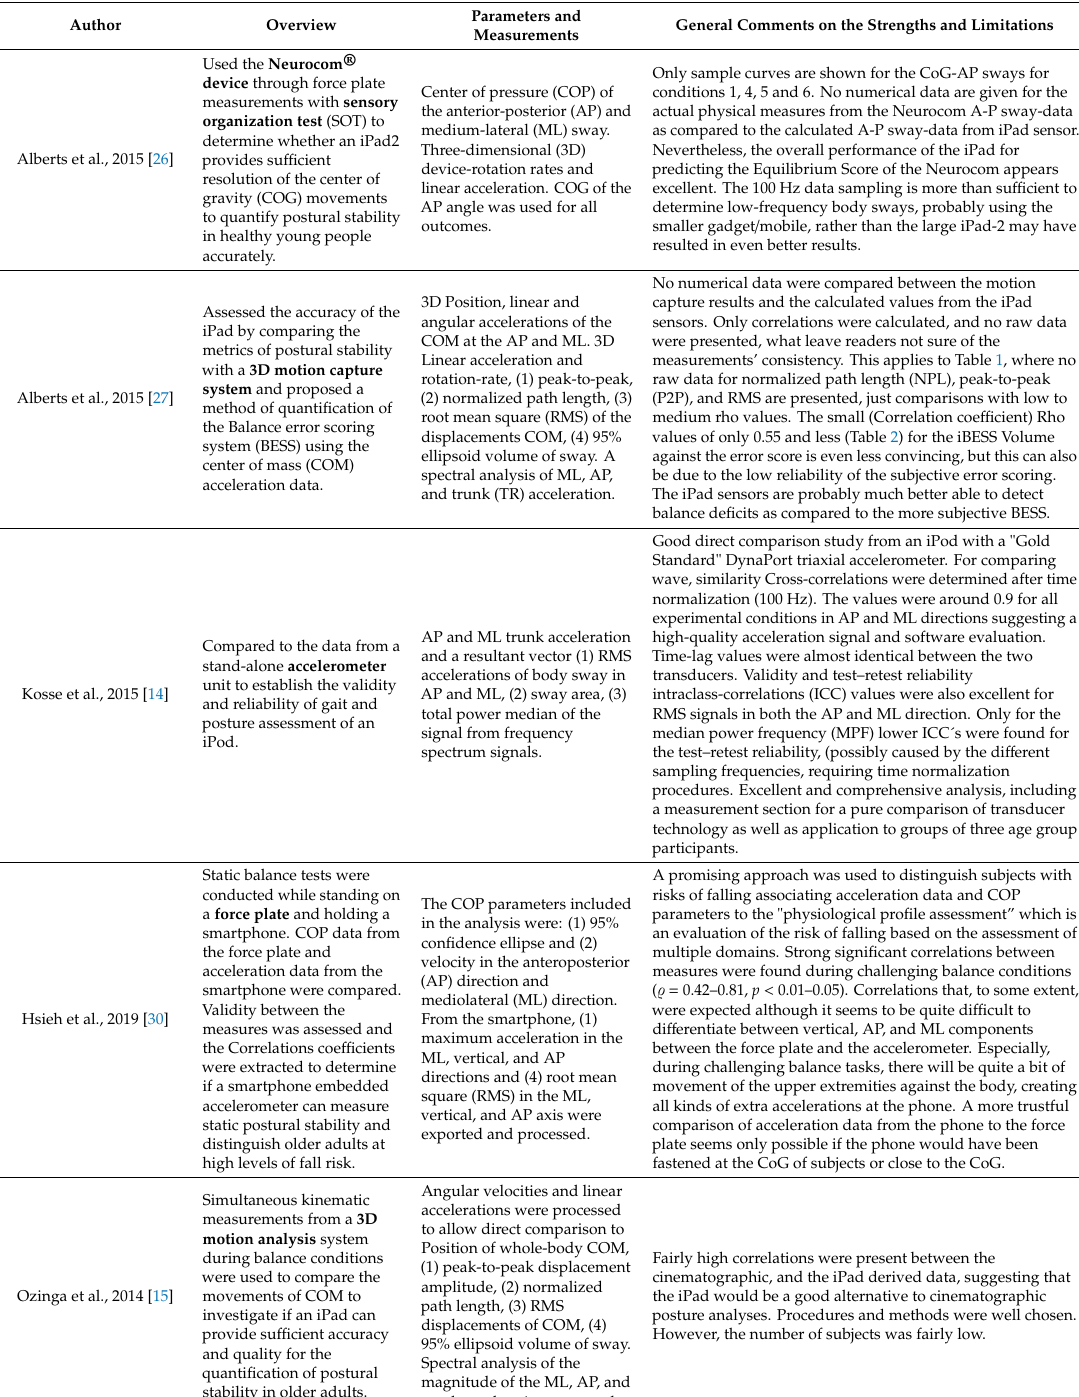
TableA3. Theprimarysignalprocessingparametersusedinquantitativecontinuousdatameasurements as stated in the 9